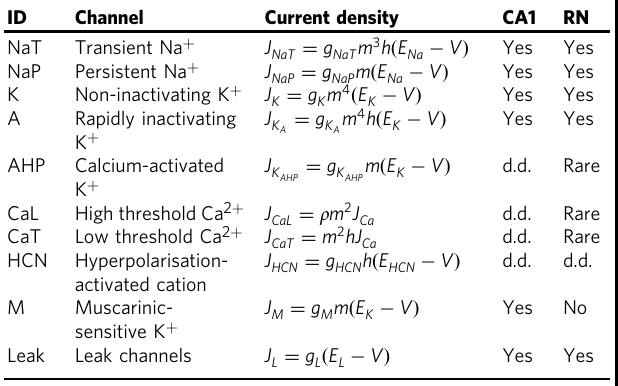
RN respiratory neuron, d.d. distal dendrite Ion current densities J α of conductance models as a function of ionic conductances g α , reversal potentials E Na (cid:3) þ 45mV, E K (cid:3) (cid:2) 90mV, E HCN ¼ (cid:2) 43mV 70 and maximum calcium current J Ca The ionic currents of the solid-state model I α ¼ ð I m (cid:2) I h Þ θ ð I m (cid:2) I h Þ are given by Eq. (10). Prevalence of ion channels in CA1 neurons 48 and respiratory neurons 55,56 distinguishing soma and distal dendrites